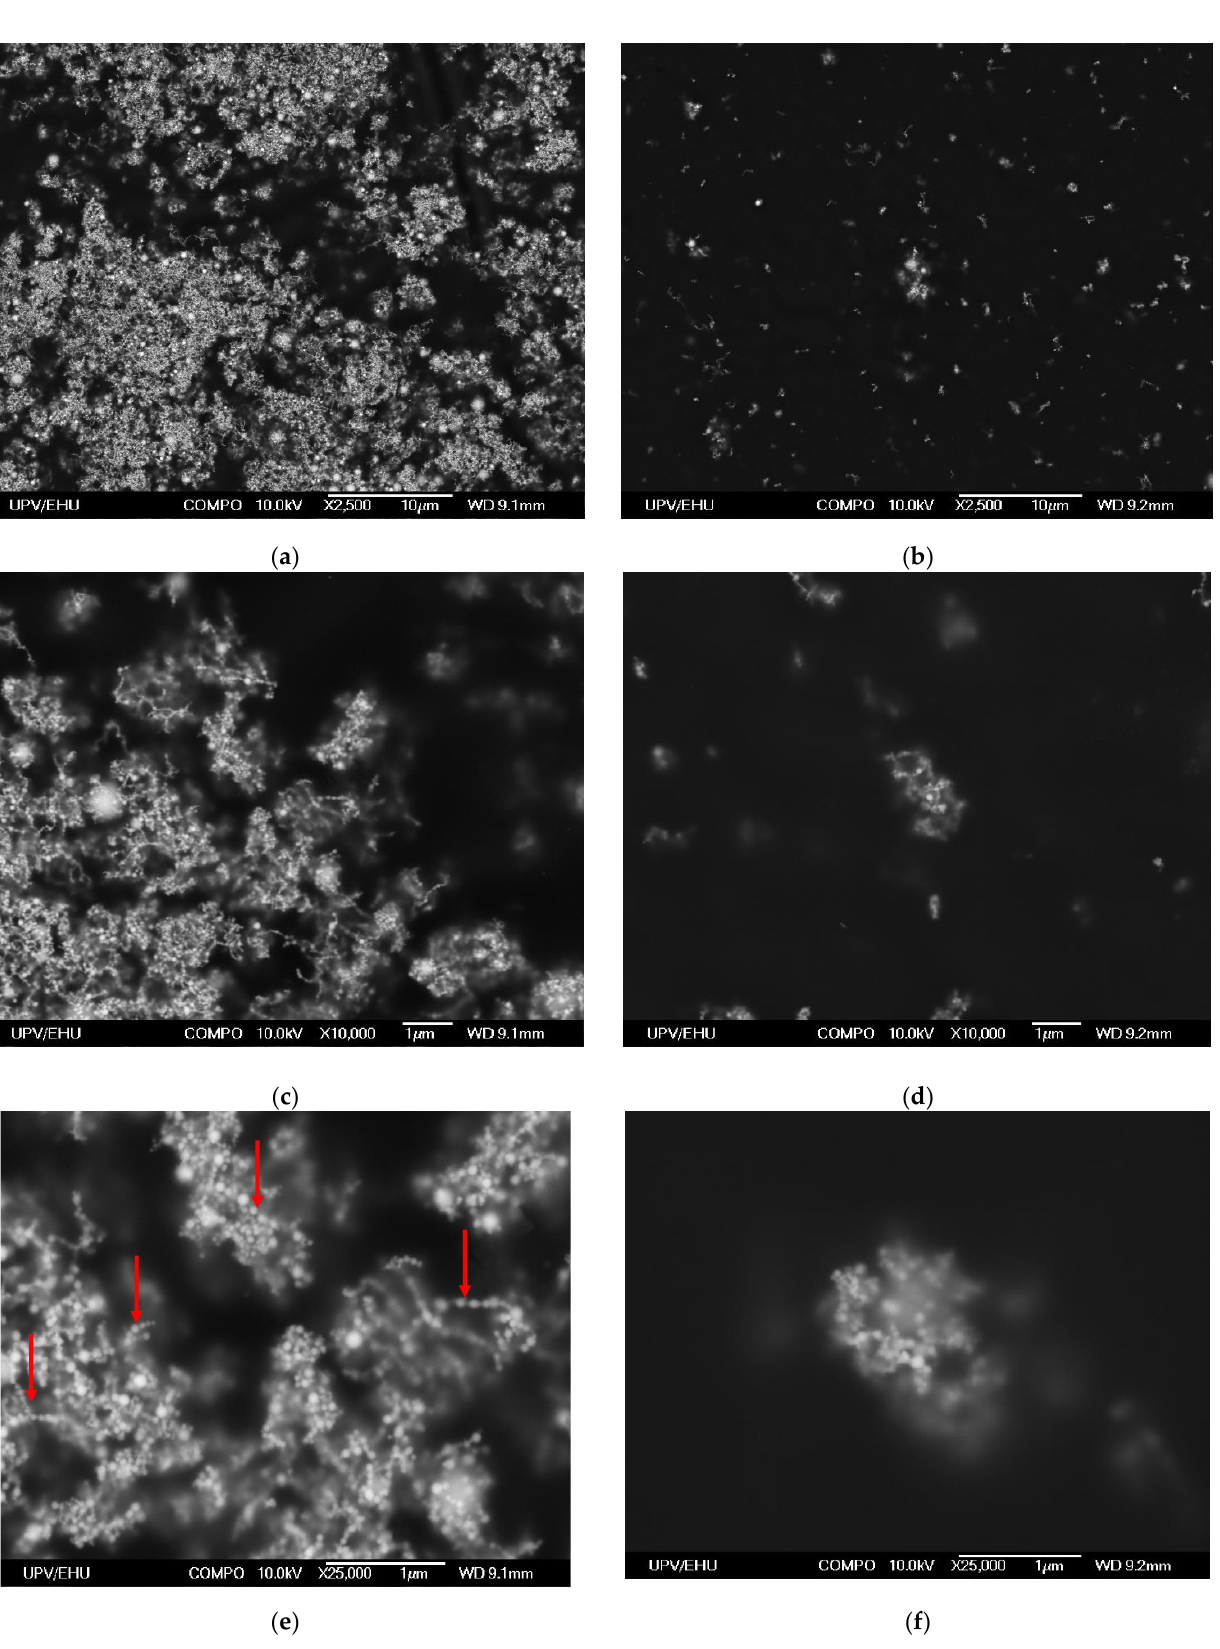
Figure 6. Surface properties of selected GE/Ni composites evaluated using scanning electron microscopy at different magnifications: ( a , c , e )—GE/69 wt.% of Ni and ( b , d , f )—GE/10 wt.% of Ni. “Chain” aggregates indicated by the red arrows.